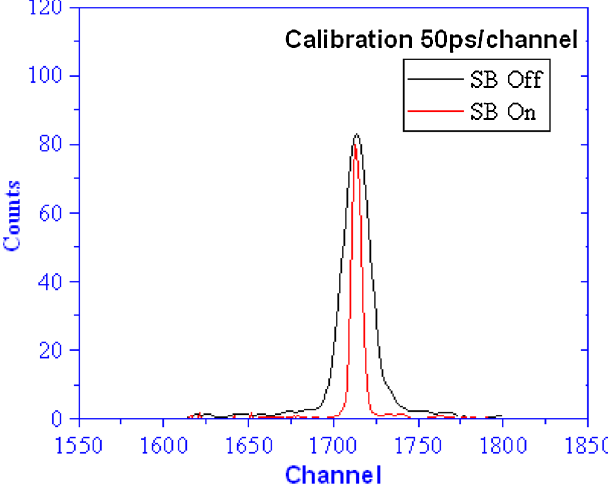
FIG. 14. (Color) The mechanical tuner with the SS bellows and shaft to pull/push the niobium convolutions. FIG. 15. (Color) Pulse length of 28 Si beam at the linac entrance.